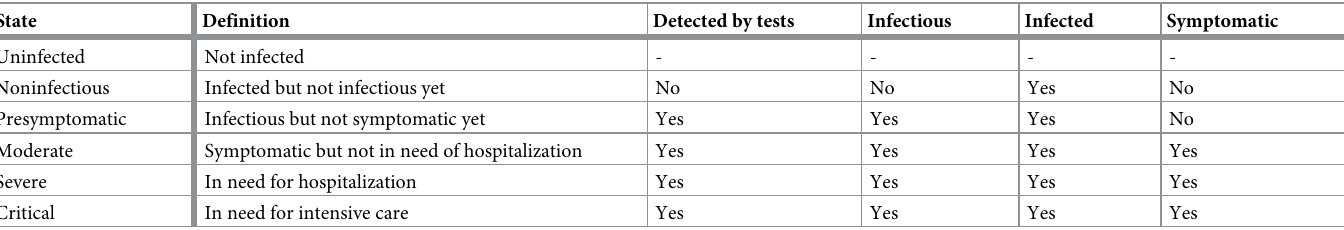
Table 1. Definition of status.